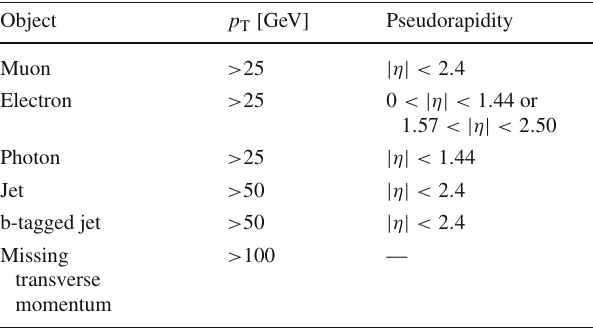
Table 2 Summary of object selection criteria discussed in Sect.